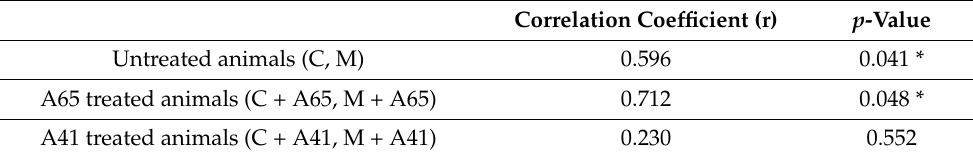
Table 3. The effects of AM6545 and AM113 on correlation between albumin excretion rate (AER) and kidney level of the transforming growth factor beta 1 (TGF β 1).